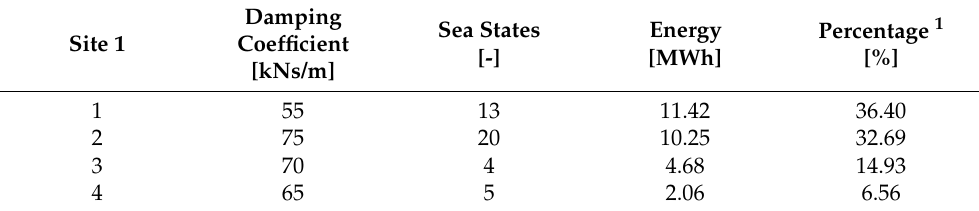
Table 5. Optimal damping coefficients contributed the most to total annual energy.